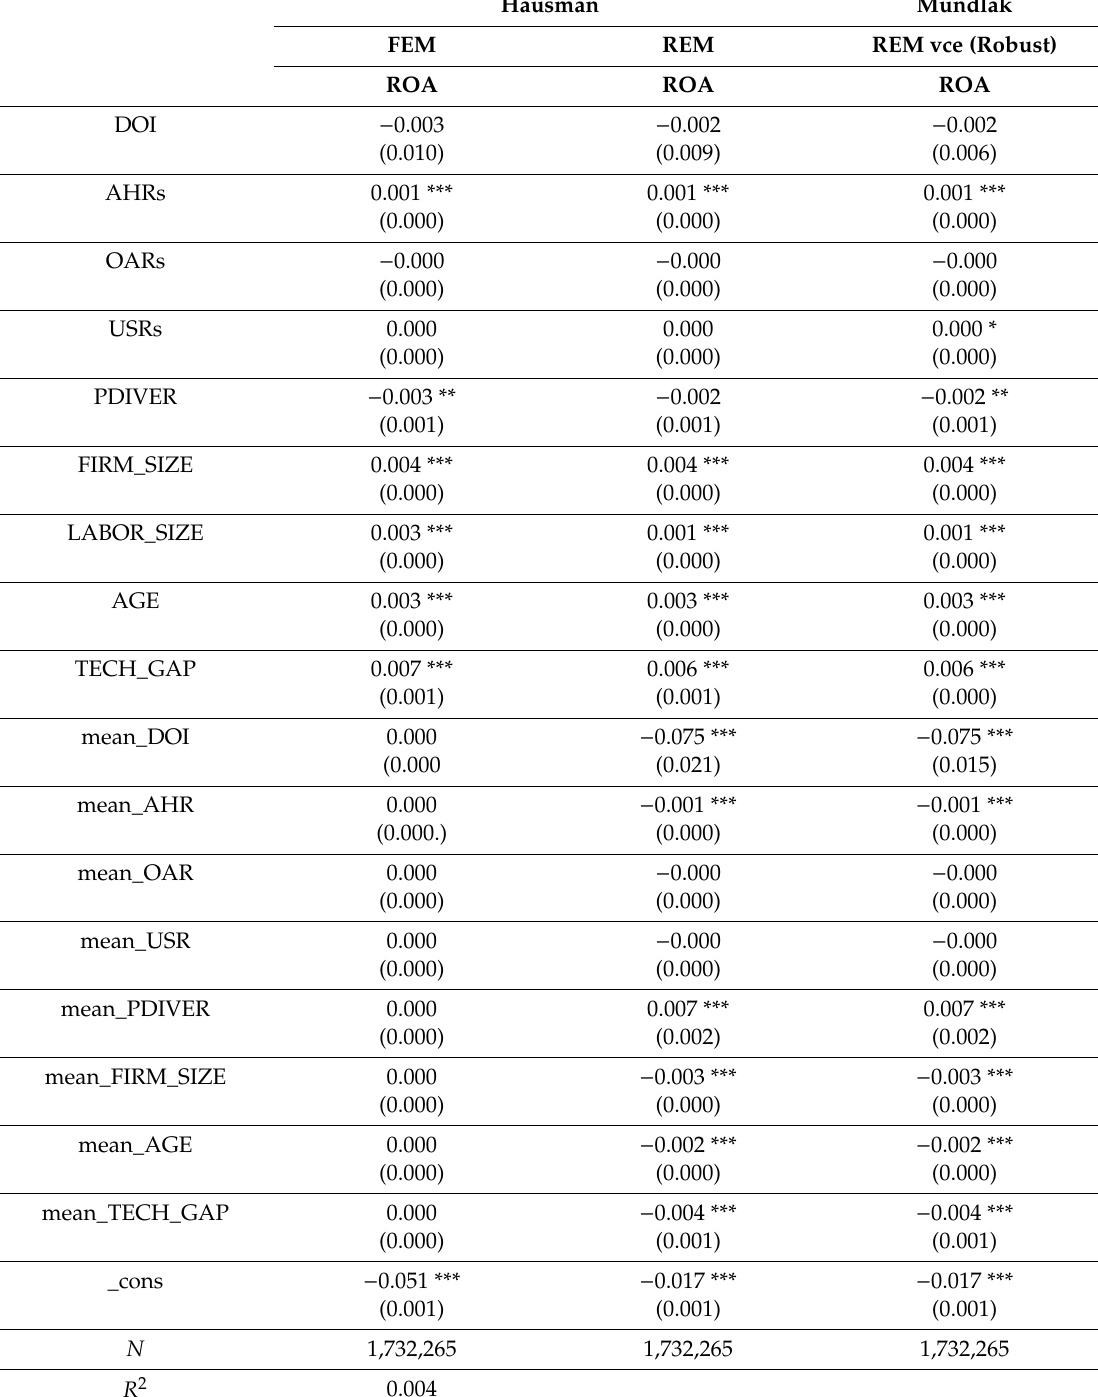
Table A1. The coe ffi cients of Fixed E ff ect Model (FEM) and Random E ff ect Model (REM).